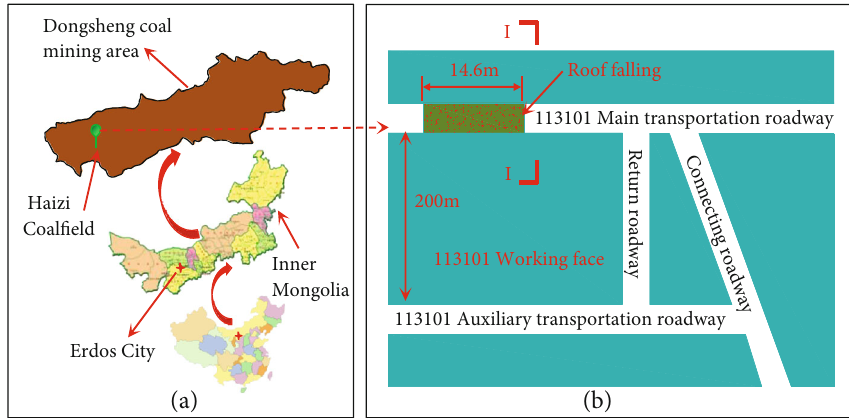
Figure 1: Coal mine position and roadway arrangement plan ((a) position of Haizi Mine area; (b) arrangement plan of roadway where the caving accident occurred).